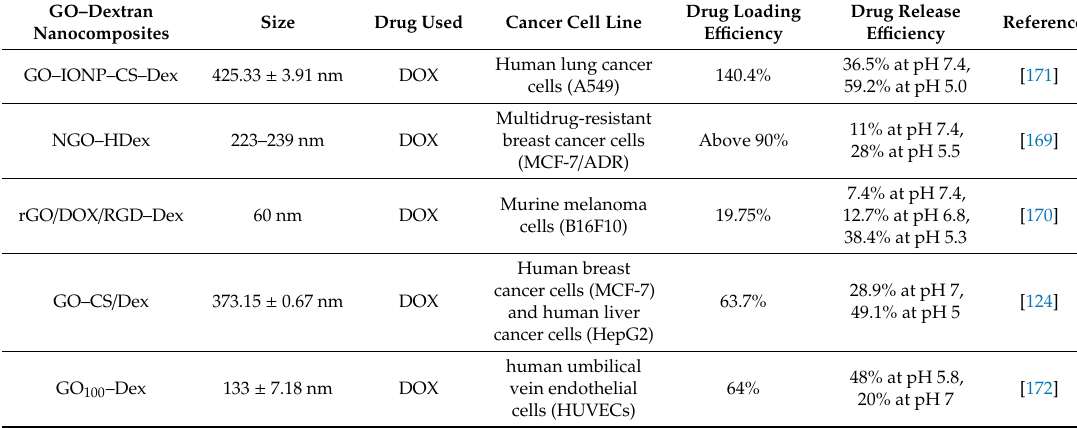
Table 5. The graphene oxide (GO)–dextran (Dex) composites, their size, the drug used, the type of cancer cell treated, drug loading, and release e ffi